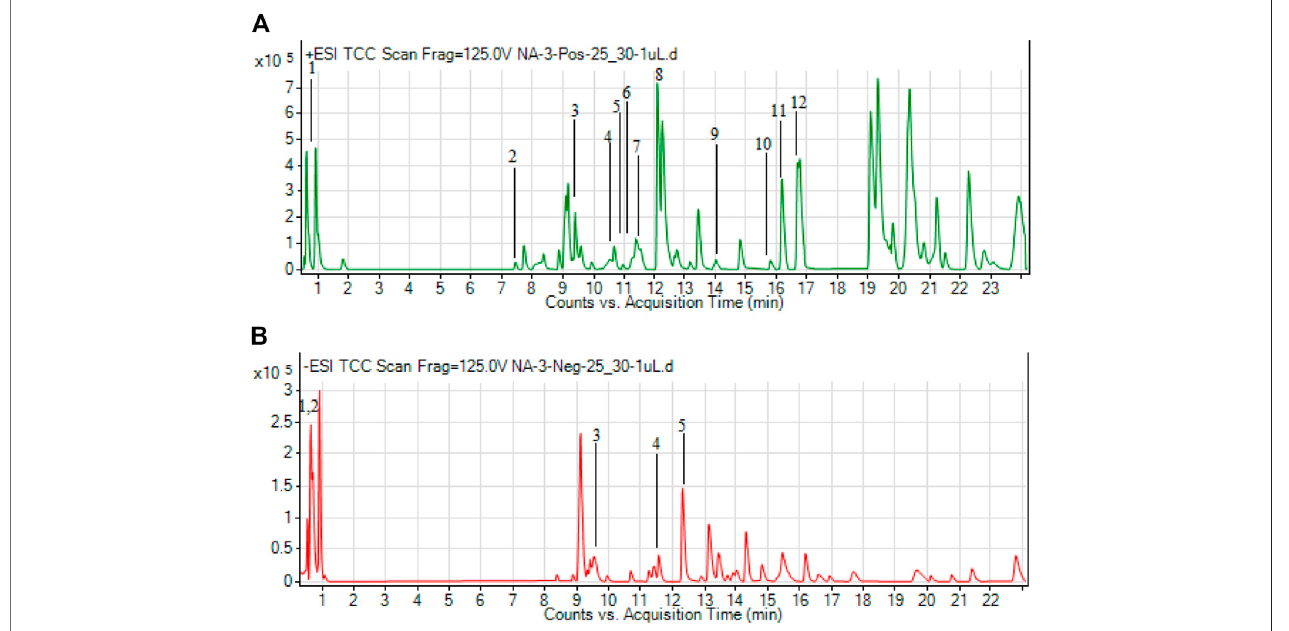
FIGURE 1 | Total ion chromatograms (TICs) of ethanolic extract of C. gigantea (L.) Dryand leaves ethanolic in positive (A) and negative (B) ionization modes.